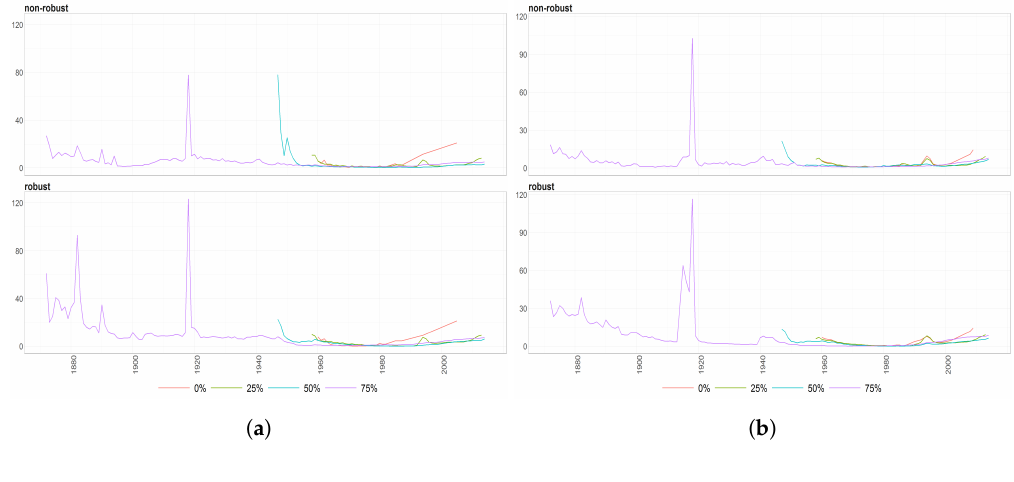
Figure 23. The Mahalanobias distances obtained using PPCA for female ( a ) and male ( b ) population of Death Rates over time (x axis). Different colours of lines correspond to the cases of different percentages of maximal missing entries in rows (light blue (75%), dark brown (50%), dark blue (25%), light brown (0%)). Every subfigure is divided into two subplots corresponding to robust estimation of standard divinations (upper plot) and sample one (bottom